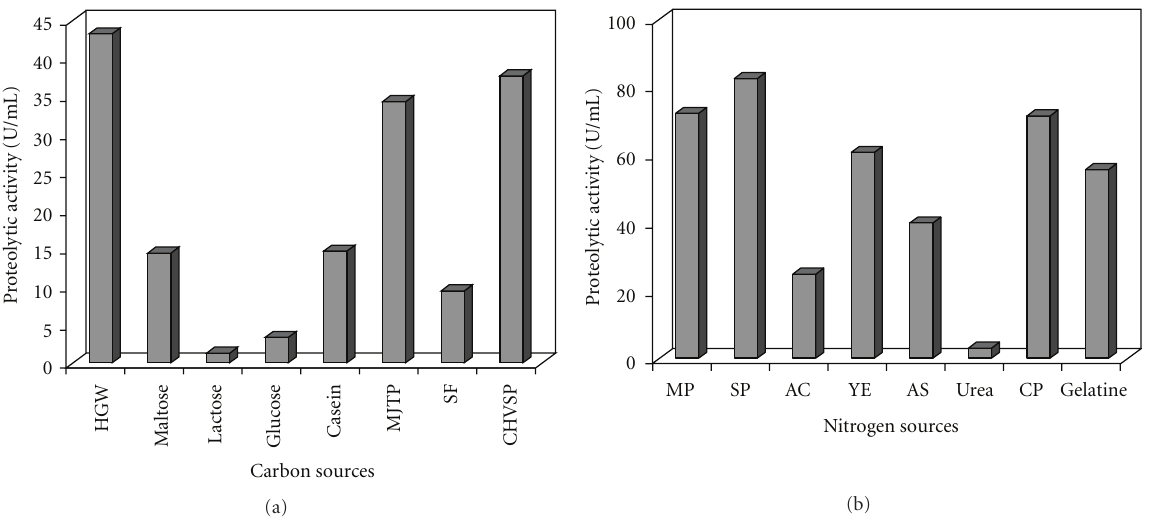
Figure 1: E ff ects of carbon sources at 10 g/L (a); nitrogen sources at 5g/L (b) on the production of proteolytic activity by A. niger I1. HGW: hulled grain of wheat, MJTP: Mirabilis jalapa tuber powder, SF: shrimp flower, CHVSP: combined heads and viscera sardinelle powder, MP: meat peptone, SP: shrimp peptone, AC: ammonium chloride, YE: yeast extract, AS: ammonium sulphate, CP: casein